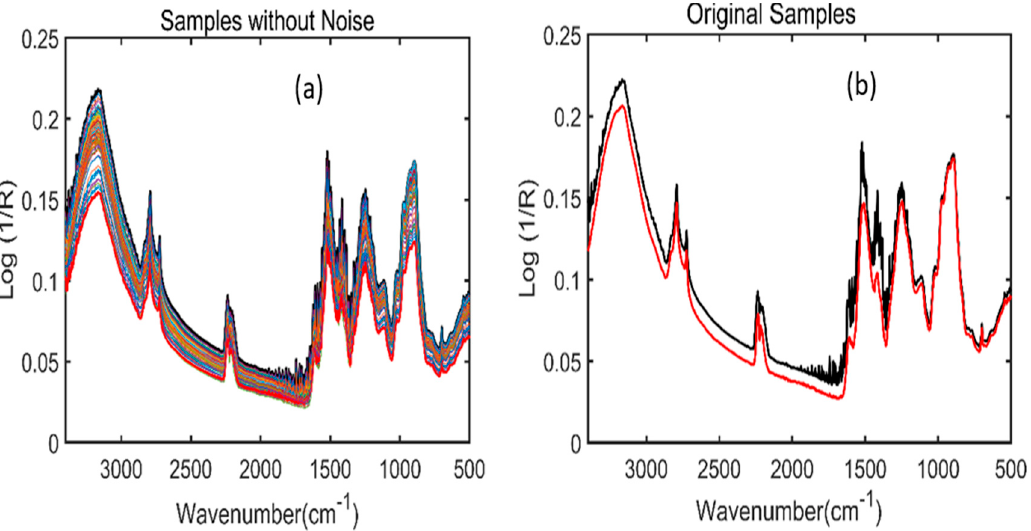
Figure 5. A total of 100 mixed samples FT − IR spectra of Arabidopsis powder samples for one concentration created by Dirichlet distribution ( a ). FT-IR spectra developed between two replicates, i.e., red drought_1 and red non-drought_1 (RD_1 and RND_20) for one variety of concentrations ( b